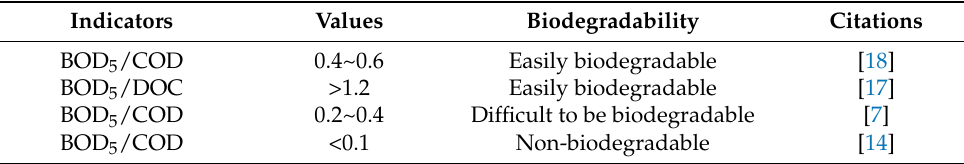
Table 1. Simple indicators for evaluation of wastewater